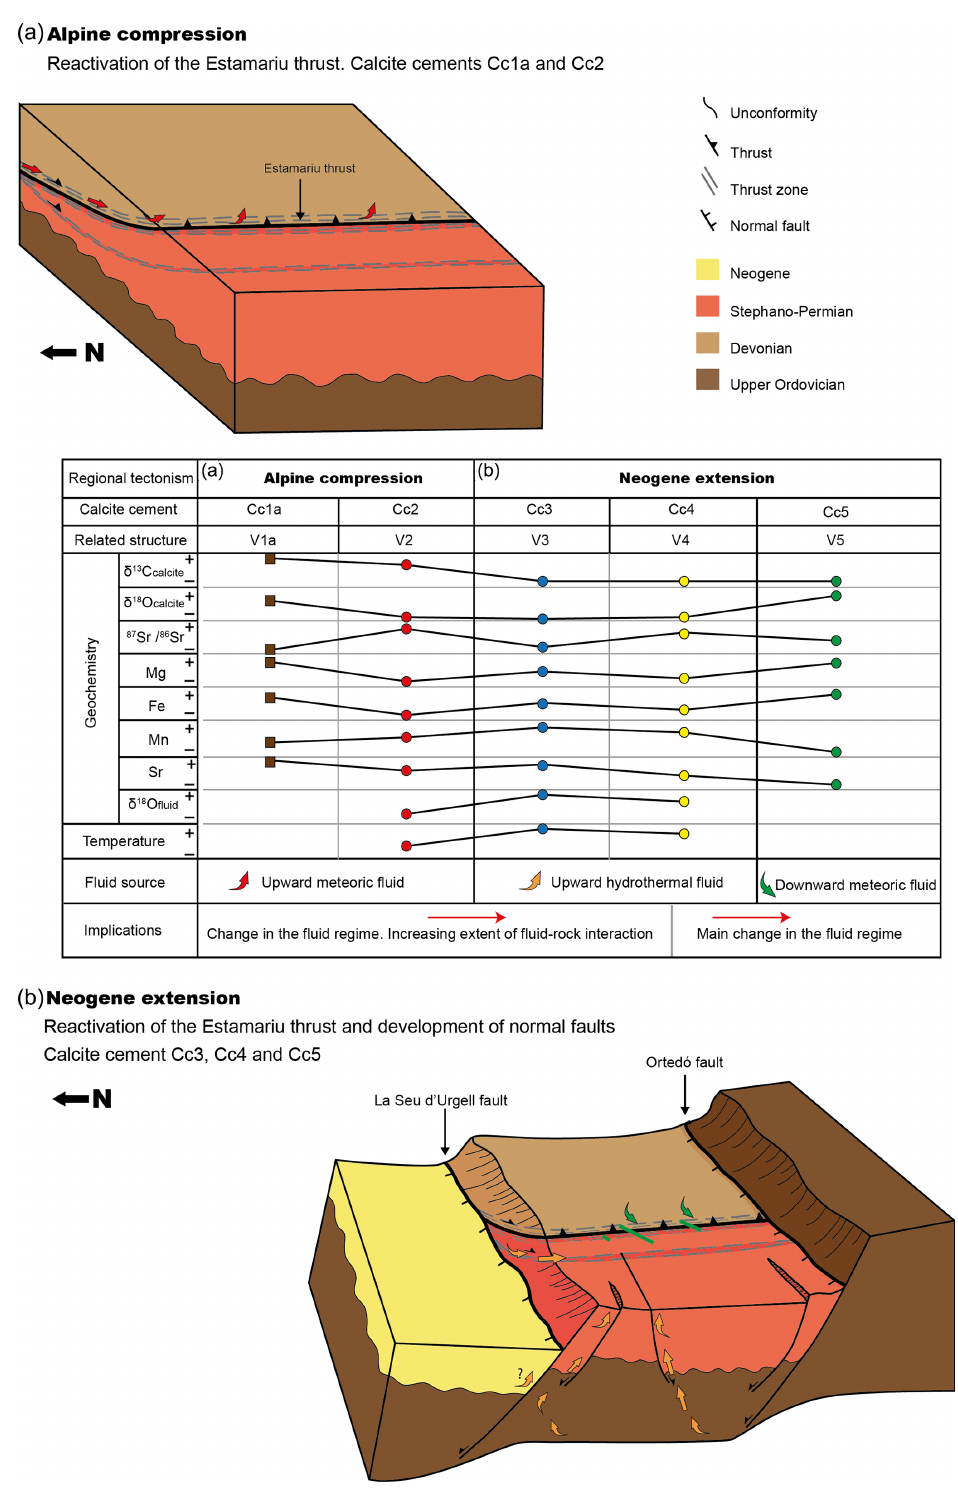
Figure 13. Tectonic and geochemical evolution of the study area (not to scale) and relationships with the evolution of the fluid system. (a) During the Alpine reactivation of the Estamariu thrust, a meteoric fluid (red arrows) interacted at depth with basement rocks and then migrated along the fault plane towards the hanging wall, precipitating cements Cc1a and Cc2. (b) During the Neogene extension, basement- derived hydrothermal fluids (orange arrows) flowed upwards through newly formed and reactivated fault zones. This fluid precipitated calcite cements Cc3 and Cc4. Finally, during ongoing deformation, meteoric fluids (green arrows) percolated in the system and precipitated Cc5, revealing a main change in the fluid